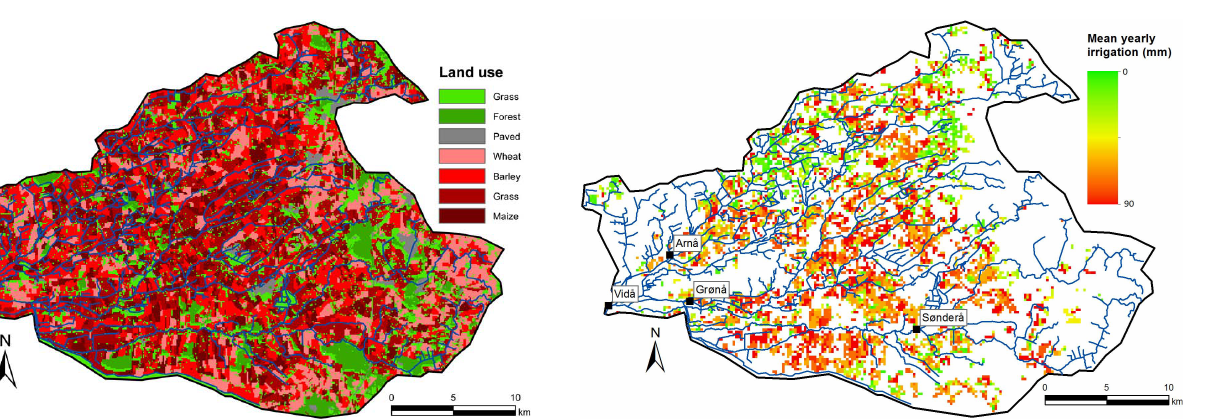
Fig. 5. Mean yearly irrigation (current scenario) in the model do- main and the locations on the stream network where discharge is